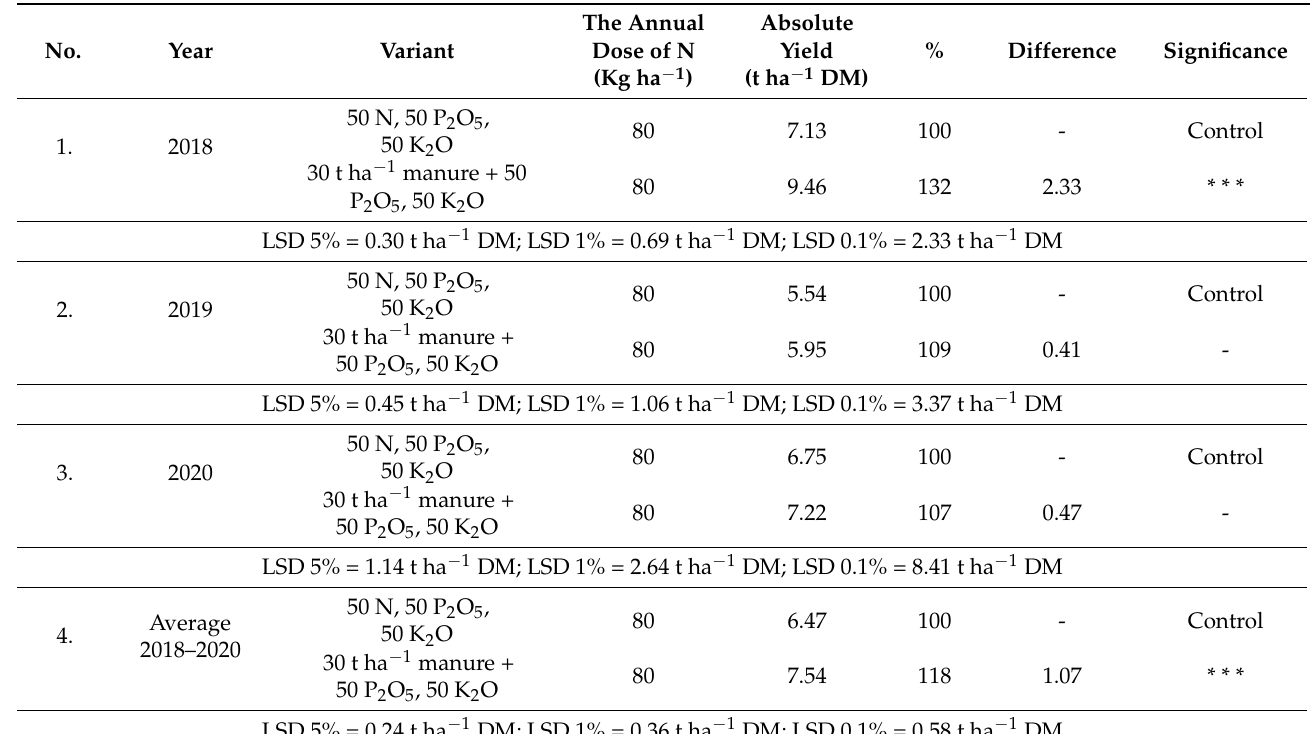
Table 3. The influence of the fertilization system on the production of temporary grassland (t ha − 1 DM,